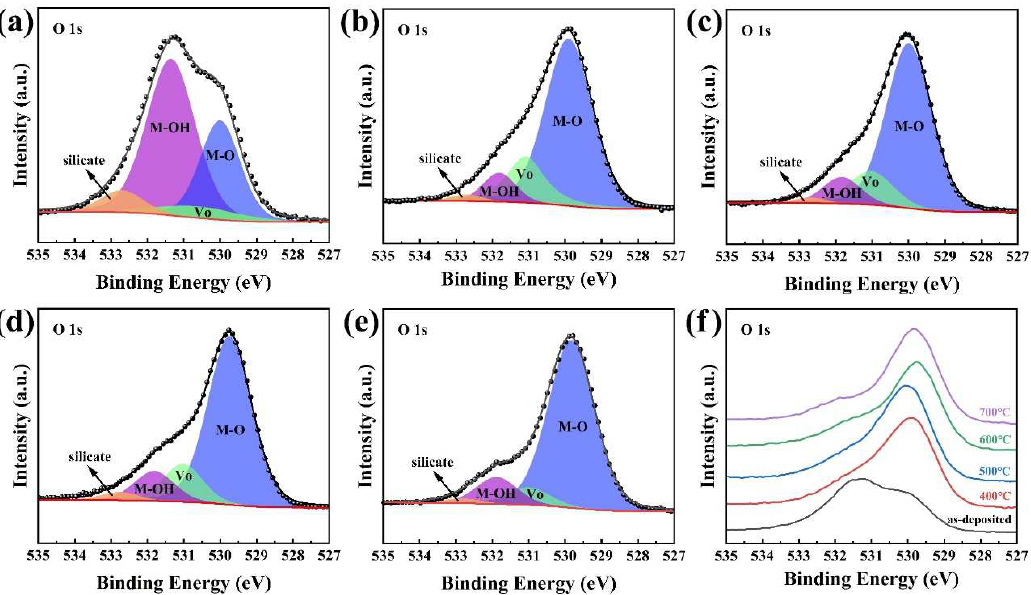
Figure 6. ( a – e ) O 1s XPS spectra of lanthanum-doped HfO 2 films at different temperatures. ( f ) O 1s XPS spectral stacking diagram. XPS spectral stacking diagram.